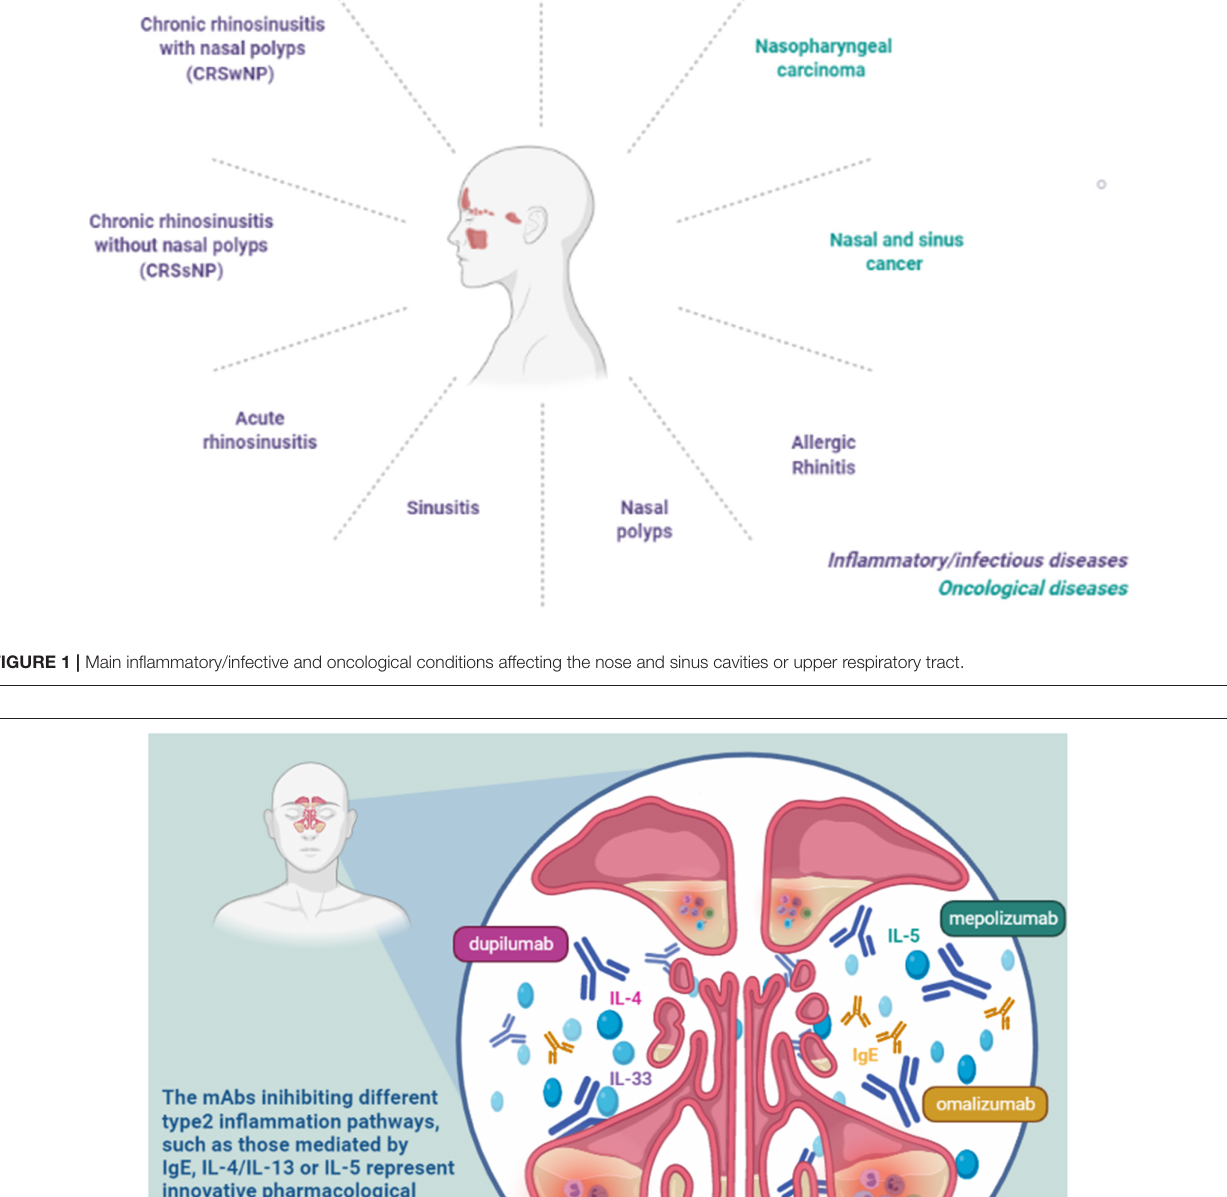
population worldwide (14). It is often associated with several co-morbidities including nasal polyps, asthma, acute infection, and obstructive sleep apnea. Based on the associated presence